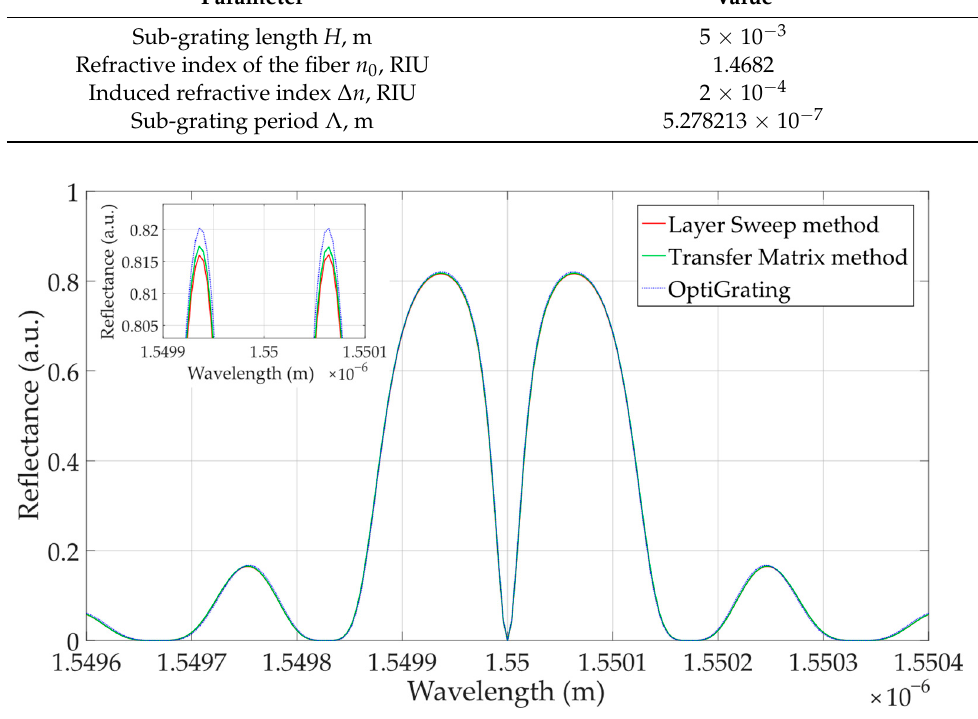
Figure 7. Simulated spectra of the π -phase-shifted FBG obtained using the Layer Sweep method (red solid line), Transfer Matrix method (green solid line), OptiGrating software (blue dotted line), and amplified spectra near the reflectance peak (insert).